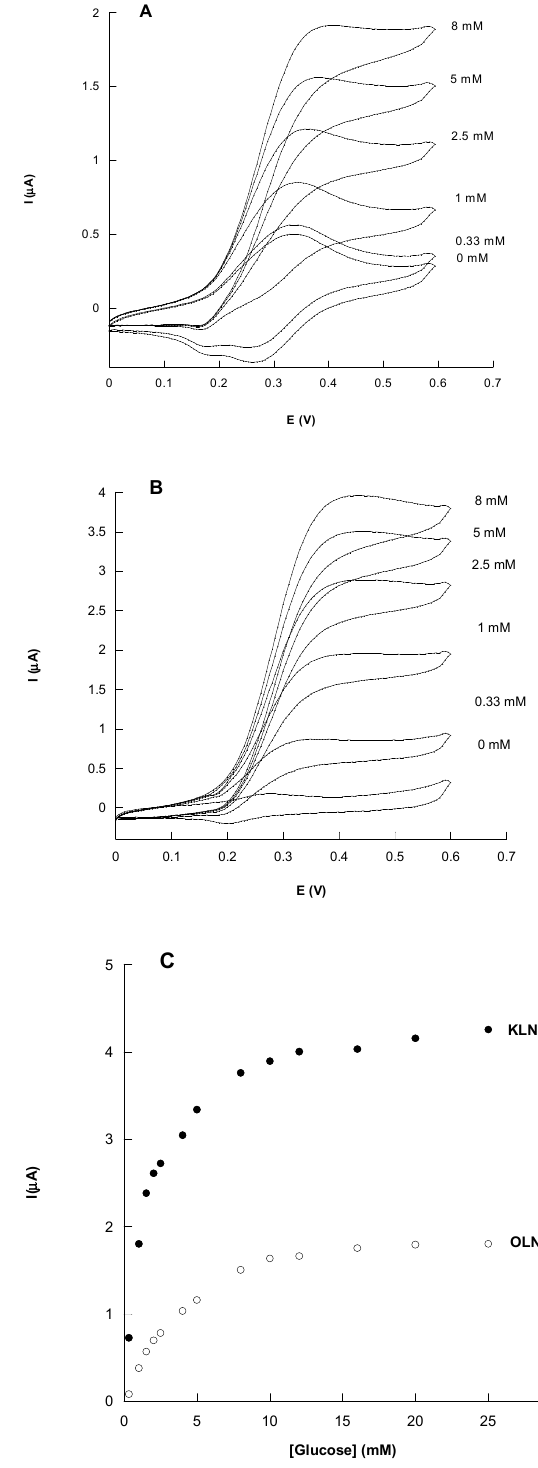
Figure 5. Cyclic voltammograms of a solution containing 0.1 mM OsCmplx at Au/SAMCys/OLNPs/Con A/GOx ( A ) and Au/KLNPs/Con A/GOx ( B ) in the absence and presence of glucose at different concentrations (0–8 mM). ( C ) Calibration plots of the glucose biosensors. Experimental conditions: N 2 -saturated in PBS buffer solution, pH 7.4, ν = 10 mVs − 1 , T = 298